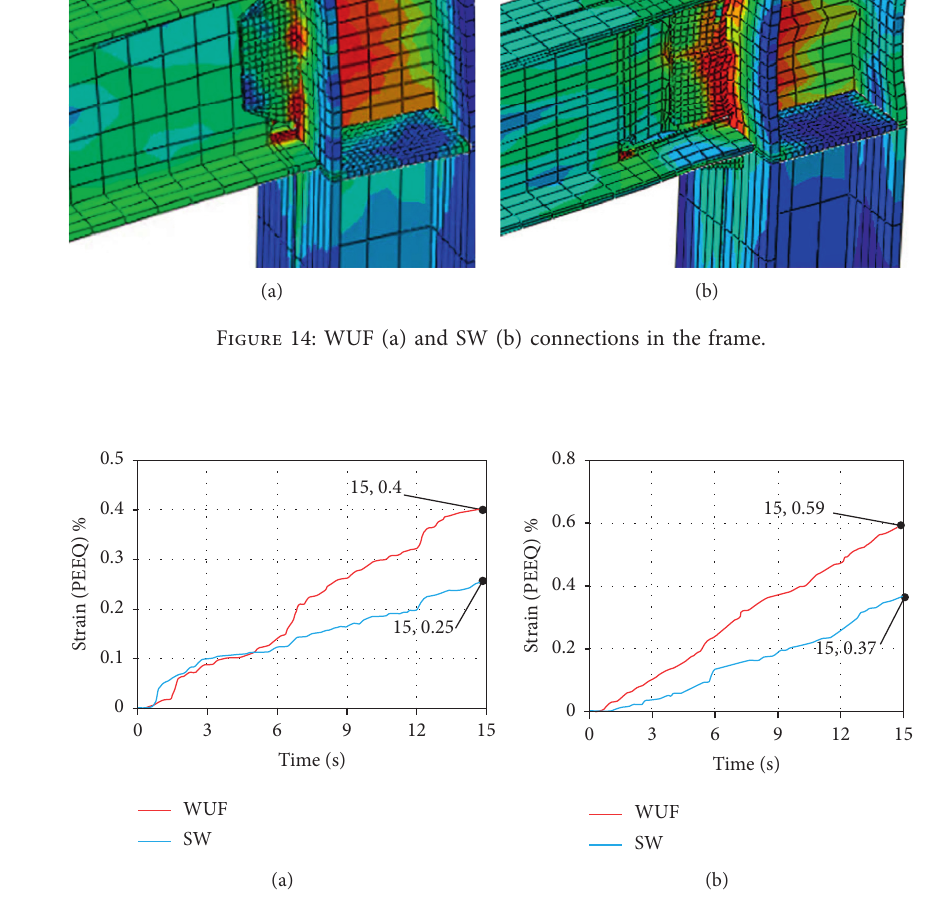
Figure 15: The strain in the connection panel zone (a) and the weld area of the beam to the column connection